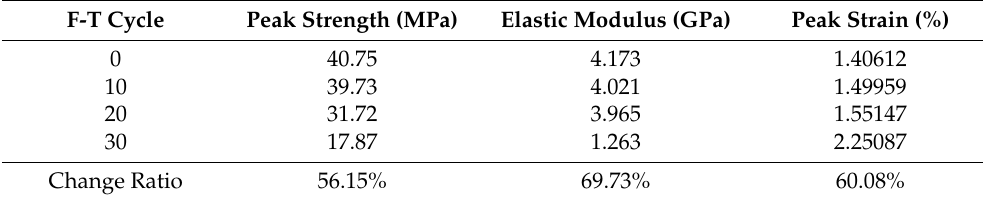
Figure 7. The influence of the number of freeze-thaw cycles on physical and mechanical parameters. ( a ) Stress-strain curve; ( b ) peak strength and elastic modulus; and ( c ) peak strain and porosity. Table 5. The statistical results of mechanical parameters under different freeze-thaw cycles. F-T Cycle